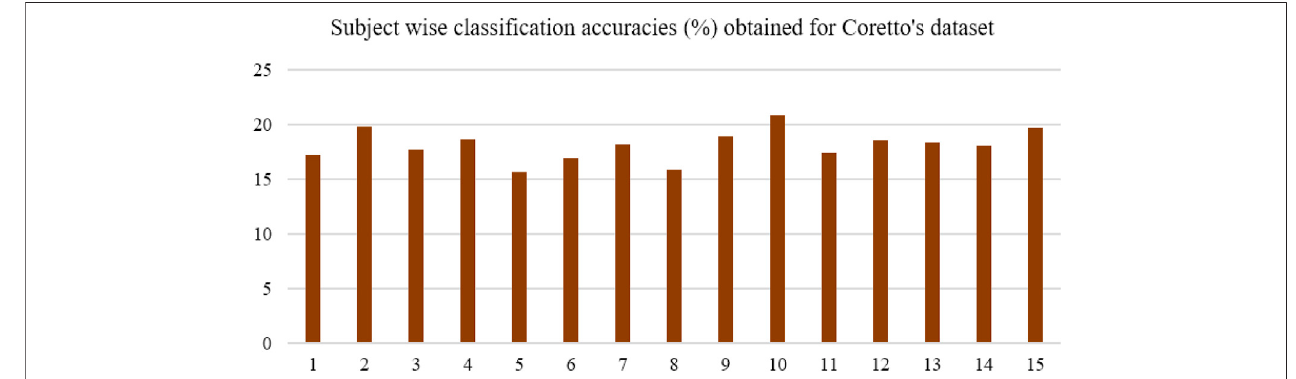
FIGURE 6 | Classi fi cation accuracy obtained for Coretto ’ s data using selected feature set with SVM classi fi ers. Accuracy was lower than the chance level for subjects fi ve and eight, while for others, it was higher than the chance level (16.6%).